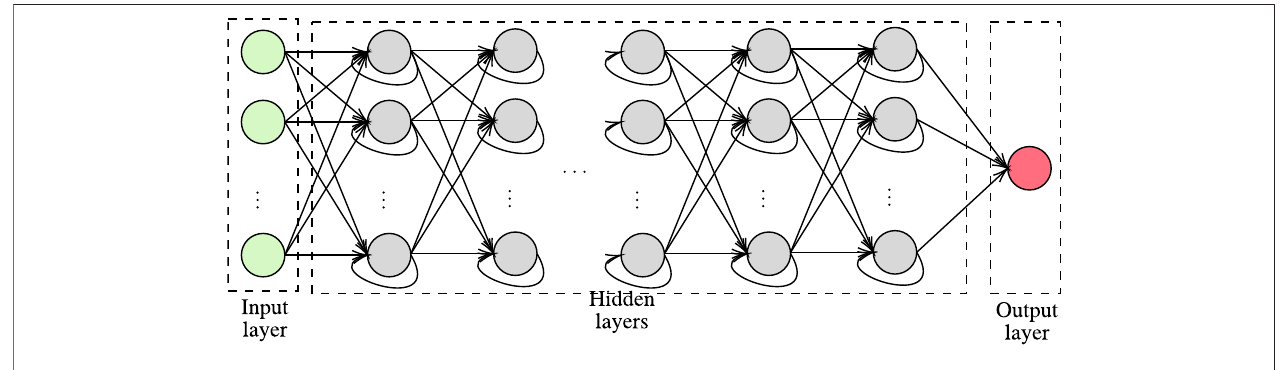
FIGURE 5 | RNN structure.